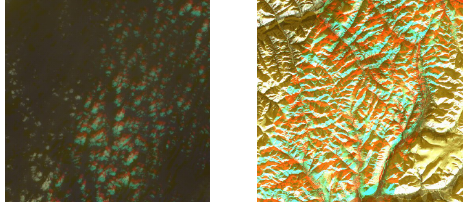
Figure 4. Example of images with not correctly aligned bands found in our dataset.